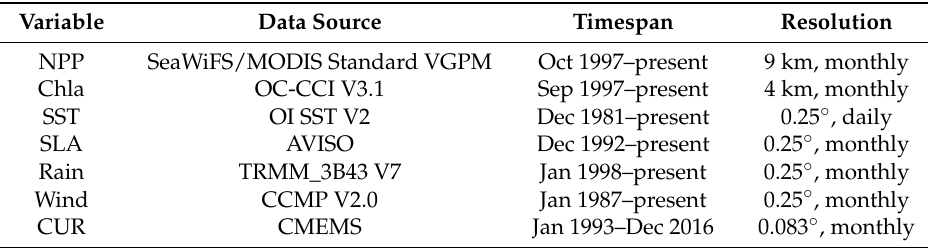
Table 1. Sources, timespans, and temporal–spatial resolutions of the